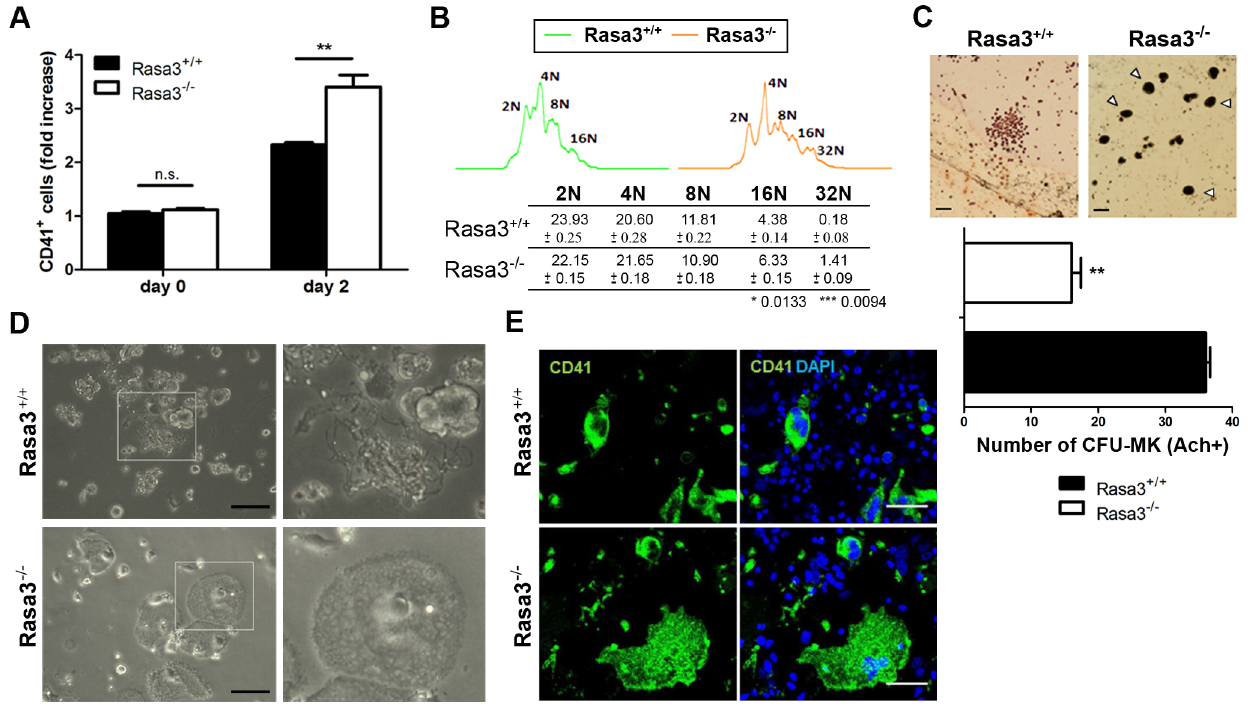
Figure 3. Abnormal megakaryocyte differentiation from Rasa3 2 / 2 fetal liver cell culture. Fetal liver cell (FLC) were isolated from E12.5 Rasa3 + / + and Rasa3 2 / 2 embryos. A . Percentages of CD41 + megakaryocytes were determined at day 0 and 2 days after TPO treatment in 6 Rasa3 + / + and 8 Rasa3 2 / 2 FLC cultures by flow cytometry. Results are expressed as fold of increase of CD41 + cells, considering the percentage of Rasa3 + / + CD41 + cells at day 0 as 1. Statistics (unpaired t test): **: P , 0.01. B . Increased megakaryocyte ploidy in FLC culture at day 2 after TPO treatment. Representative images of DNA content in Rasa3 + / + and Rasa3 2 / 2 CD41 + megakaryocytes. The table shows a quantification of the percentages of individual ploidy classes of FLC-derived CD41 + megakaryocytes (mean 6 SEM). Statistics (unpaired t test, n=6): *: P , 0.013; ***: P , 0.009. C . CFU-Mk assay from Rasa3 + / + and Rasa3 2 / 2 FLC. Representative images of a Rasa3 + / + CFU-Mk with immature megakaryocytes of about 10 m m of diameter, and of Rasa3 2 / 2 mature megakaryocytes of about 30 m m of diameter (arrowheads). Scale bars: 50 m m. The graph represents the number of CFU-Mk formed by 5 Rasa3 + / + and 3 Rasa3 2 / 2 independent FLC cultures after 3 days (mean 6 SEM). Statistics (unpaired t test): **: P , 0.01. D. Representative images of FLC Rasa3 + / + (upper panels) and Rasa3 2 / 2 (lower panels) cultures after 6 days with TPO. A digital magnification (3 6 ) of a proplatelet event in Rasa3 + / + FLC culture (right upper panel) and of an abnormal adherent megakaryocyte in Rasa3 2 / 2 FLC culture (right lower panel) are presented. In Rasa3 + / + FLC culture, 8.4 6 2.2% of megakaryocytes formed proplatelets. No proplatelet forming megakaryocyte was detected in Rasa3 2 / 2 FLC culture. Scale bars: 50 m m. E. Rasa3 + / + (upper panels) and Rasa3 2 / 2 (lower panels) FLC cultures after 6 days with TPO were stained with a CD41 antibody (green, left panels) or CD41 and DAPI (green and blue, respectively; right panels). The large abnormal adherent cell population detected in Rasa3 2 / 2 FLC culture is CD41-positive. Scale bars: 50 m